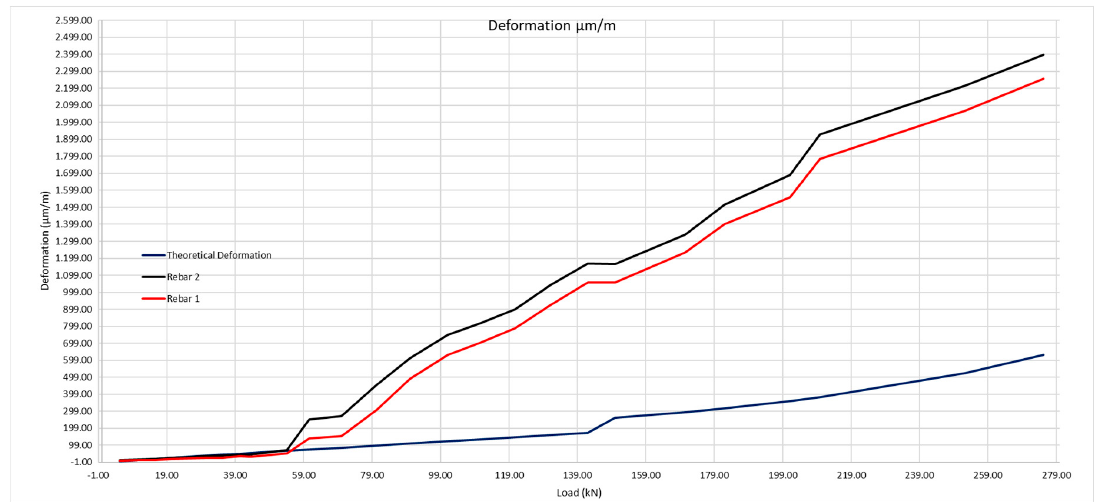
Figure 23. Theoretical deformation of the rebars compared with the real deformation obtained using the optic fiber sensors.